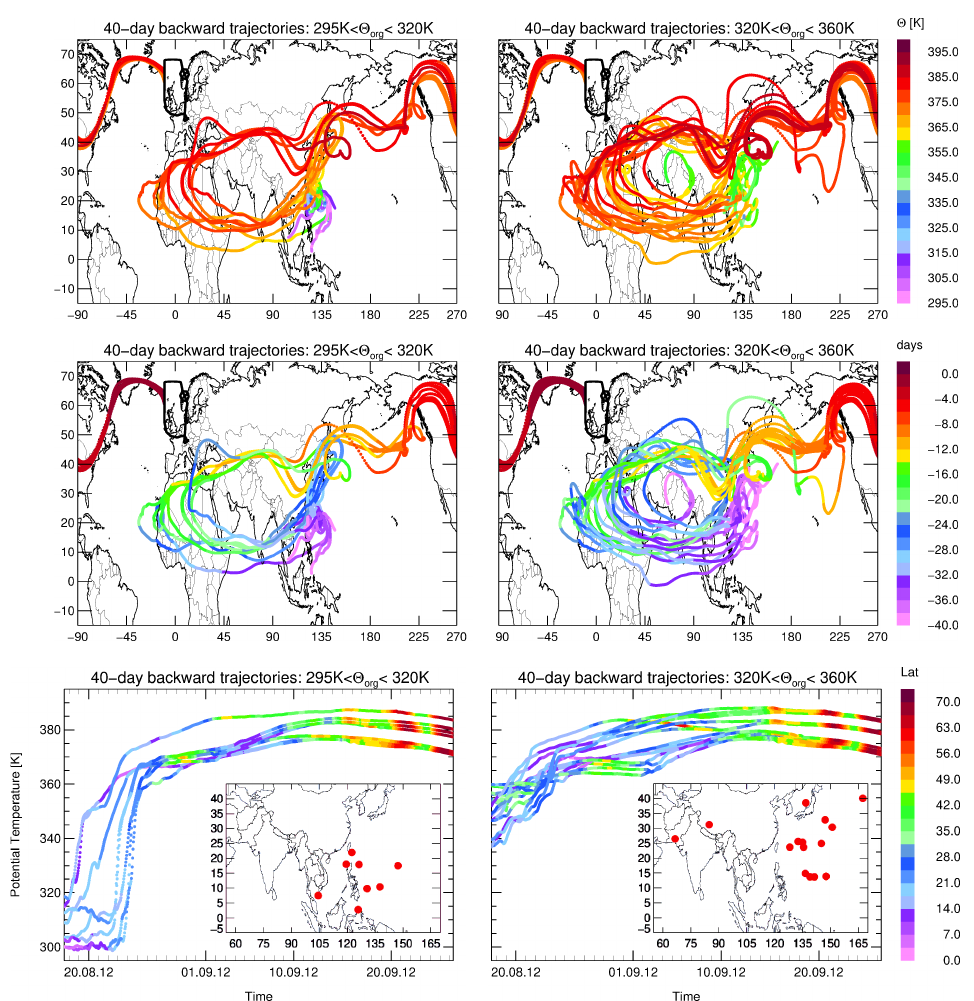
Figure 3. Different 40-day backward trajectories for (cid:50) org intervals 295–320K (left) and 320–360K (right) are shown colour-coded by potential temperature (top) and by days reversed from 26 September 2012 (middle). The flight path for the TACTS flight on 26 September 2012 (at flight time) is shown in black. Further, potential temperature versus time (inUTC) along 40-day backward trajectories (bottom) are shown. Here, the colour indicates the latitude position of the trajectories. The trajectory positions are plotted every hour (coloured dots). Large distances between single dots indicate very rapid uplift. The geographical position of the origins ( (cid:50) org ) of the 40-day backward trajectories (red dots) are shown in the embedded longitude–latitude cut. It should be noted that these geographical positions are at levels of potential temperature in the given (cid:50) org intervals and not at surface level.